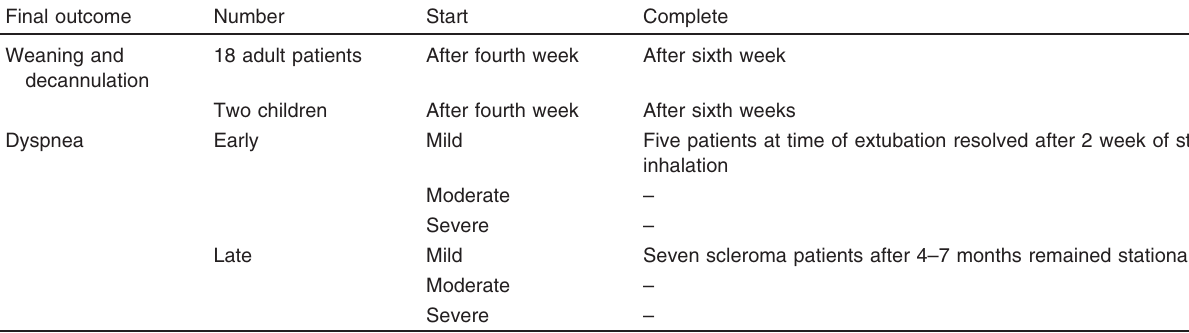
Table 3 Results (final outcome) Final